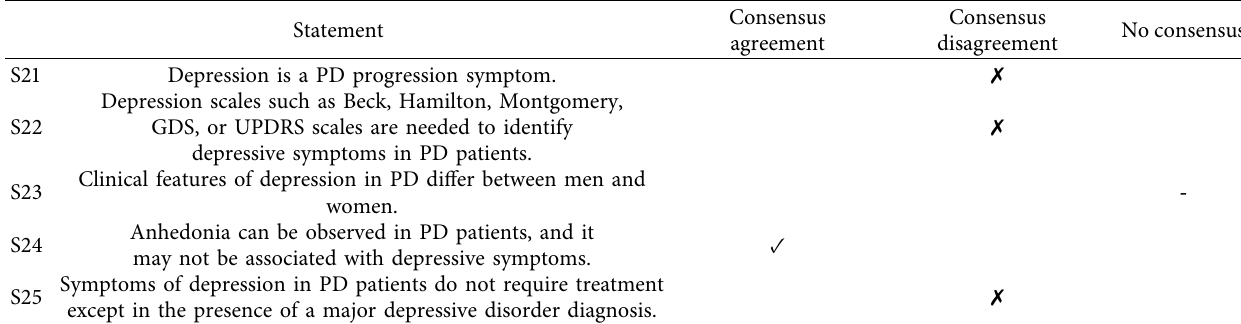
Table 3: Section III: diagnosis of depression in PD